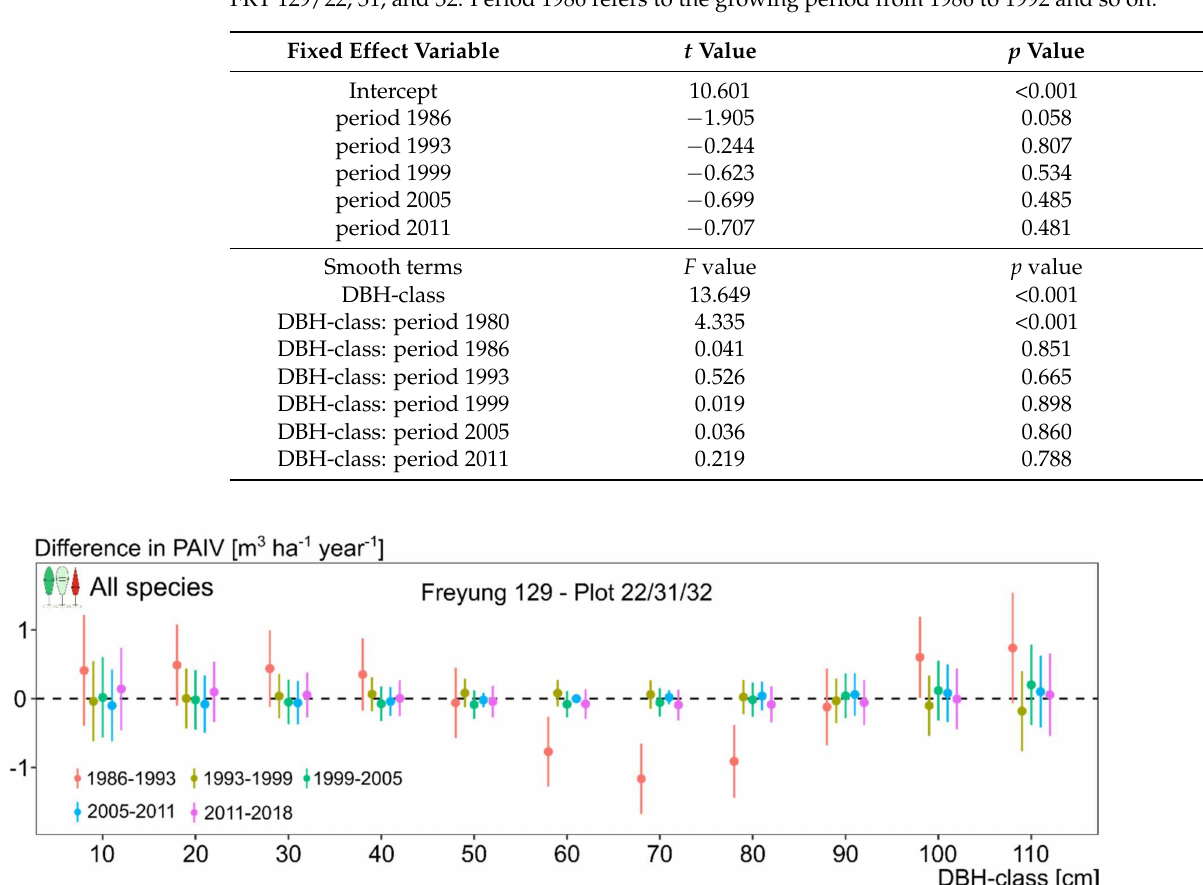
Table 5. Results of fitting the generalized additive model from Equation (7) to the data of the subplots FRY 129/22, 31, and 32. Period 1986 refers to the growing period from 1986 to 1992 and so on.